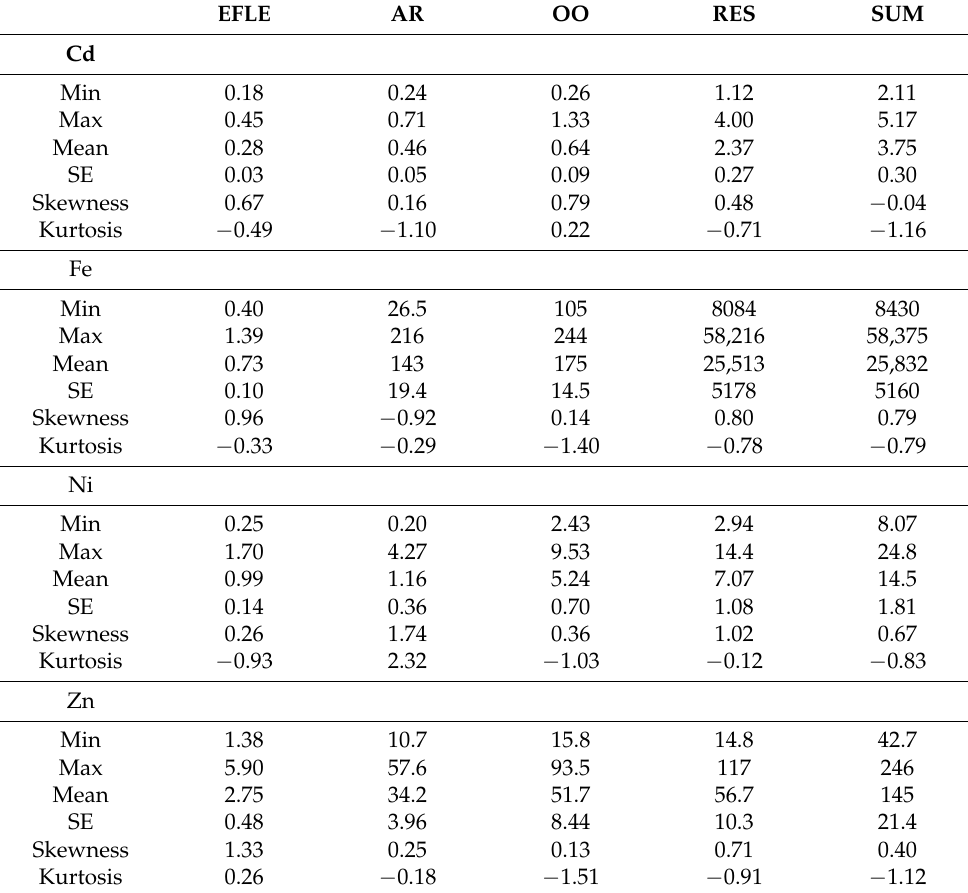
Table 2. Overall concentration (mean ± SE, µ g/g dry weight) of Cd, Fe, Ni, and Zn in the geochemical fractions of the habitat topsoils of Amaranthus viridis collected from Peninsular Malaysia. Based on 11 sampling